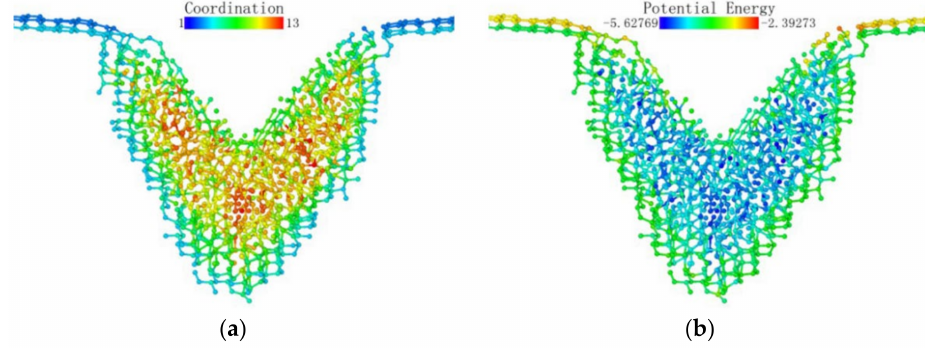
Figure 22. Atomic transient state at a stroke of 3 nm. ( a ) coordination number distribution, ( b ) poten- tial energy.